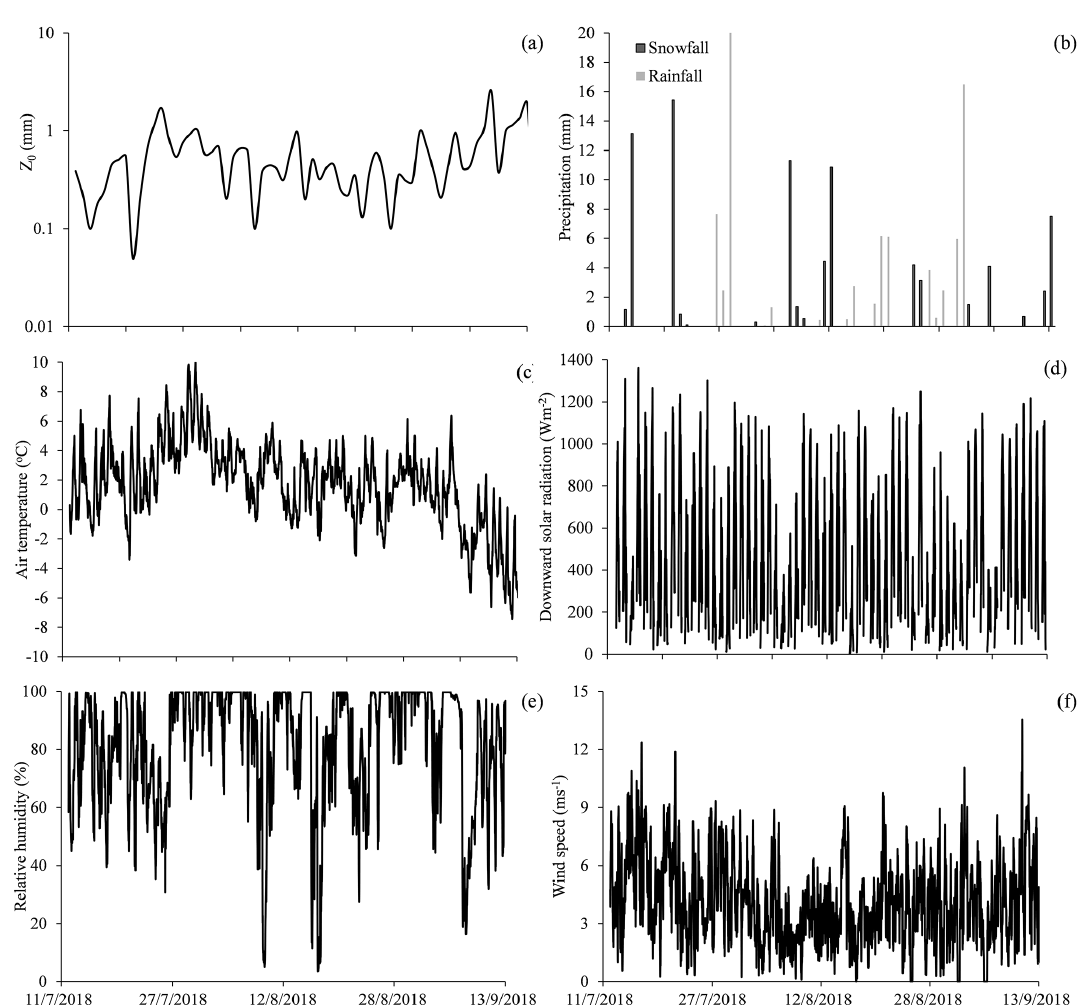
Figure 7. Weather conditions at AWS over study period: (a) precipitation, (b) air temperature, (c) incident solar radiation, (d) relative humidity and (e) wind